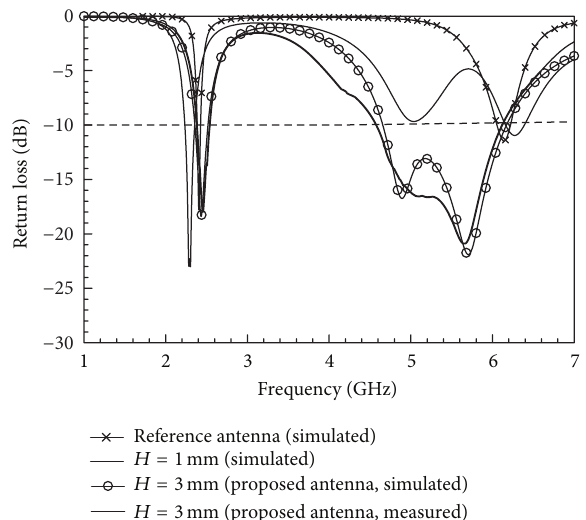
Figure 2: Simulated and measured return loss versus frequency for various 𝐻 ; 𝐿 1 = 7.5 mm and 𝐿 2 = 13 mm.